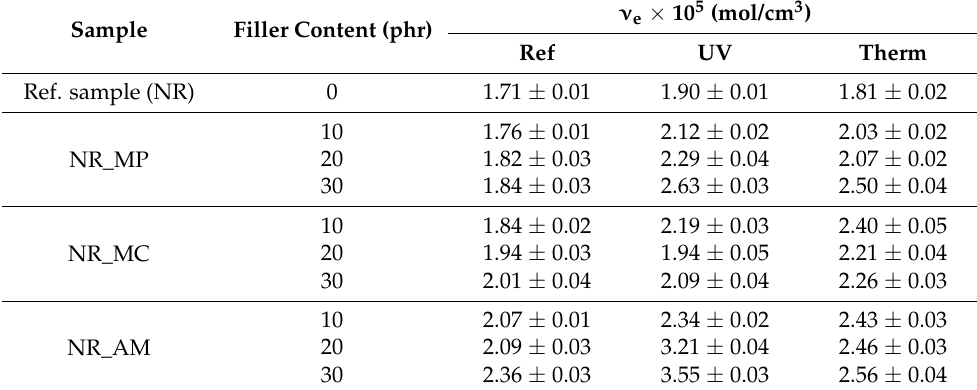
Table 4. Results of cross-linking